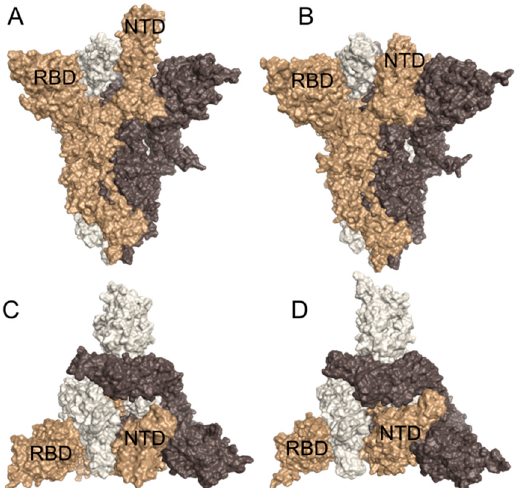
Figure 1. ( A , B ) Side view and ( C , D ) top view of Spike open (PDB: 6VSB) and Spike closed (PDB: 6VXX), respectively. Note that the NTD and RBD domains are labelled in all four panels.